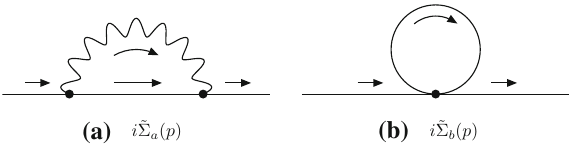
Fig. 3 Self-energy diagram for the fermion in the original massive model